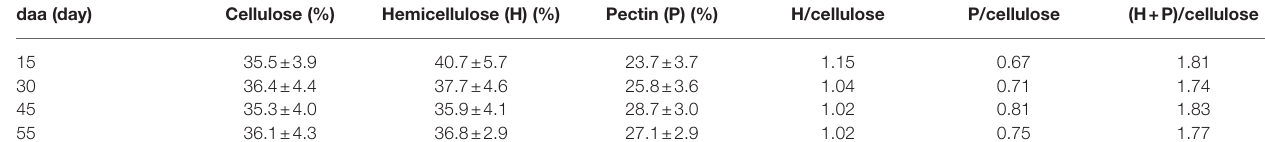
TABLE 2 | Polysaccharide fraction analysis of cuticles isolated from Cascada tomato fruits harvested at 15, 30, 45, and 55 daa. daa (day) Cellulose (%) Hemicellulose (H) (%) Pectin (P) (%) H/cellulose P/cellulose